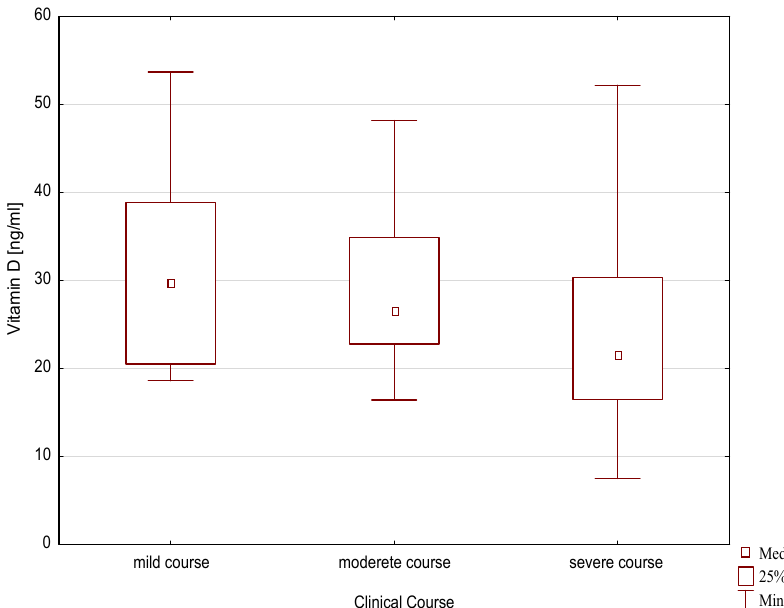
Figure 4. Vitamin D concentration depending on the clinical course of allergic disease.